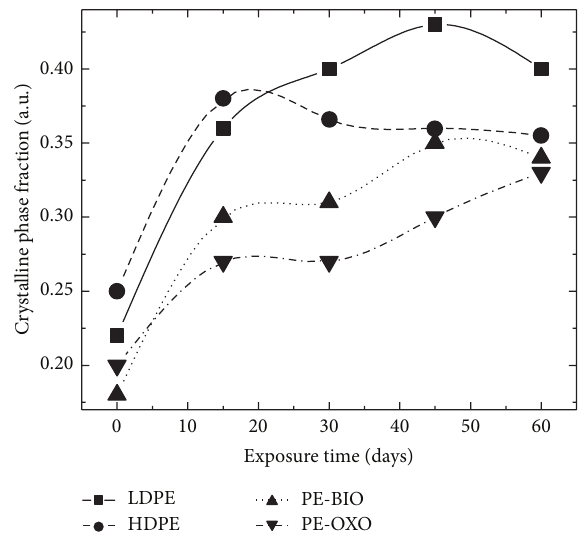
Figure 3: Vinyl index ( 𝐼 V ) of the LDPE ( ◼ ), HDPE ( 󳵳 ), PE-BIO ( 󳶃 ), and PE-OXO ( e ) films exposed to UV-B radiation.